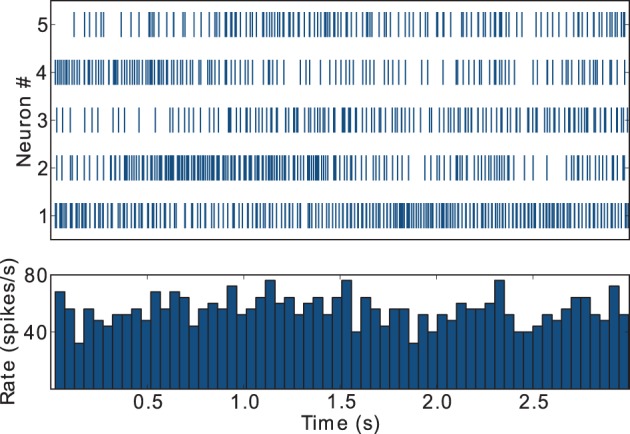
Raster plot and activity histogram (bin = 50 ms) for the five FSIs with highest firing rates in the network with weights configuration {ws = 18, wc = 113}, indicated by the black star markers in Figure 2.